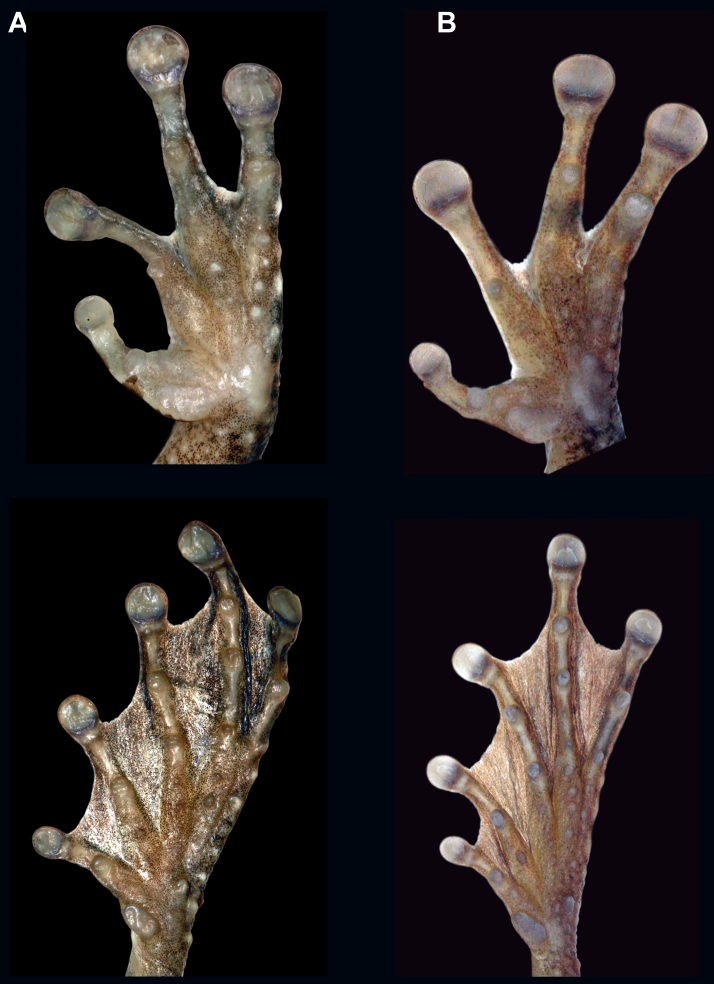
Ventral views of left hand and foot of Osteocephalus vilmae and Osteocephalus germani. A
Osteocephalus vilmae (Jibarito, Peru, SVL = 48.31 mm, CORBIDI 06469), and B
Osteocephalus germani (Comunidad Nativa Poyentimari, Peru, SVL = 49.00 mm, COBIDI 08284).